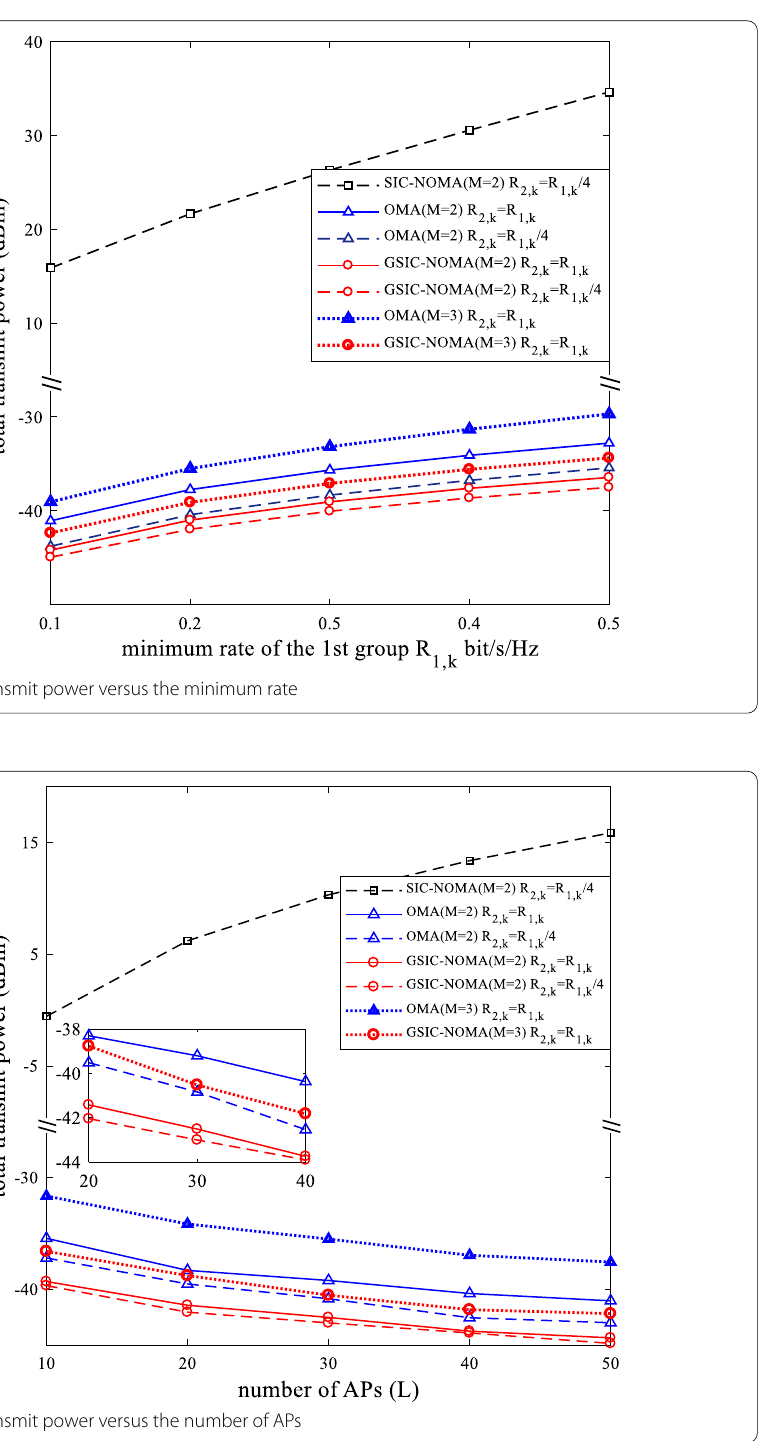
Fig. 4 Total transmit power versus the number of